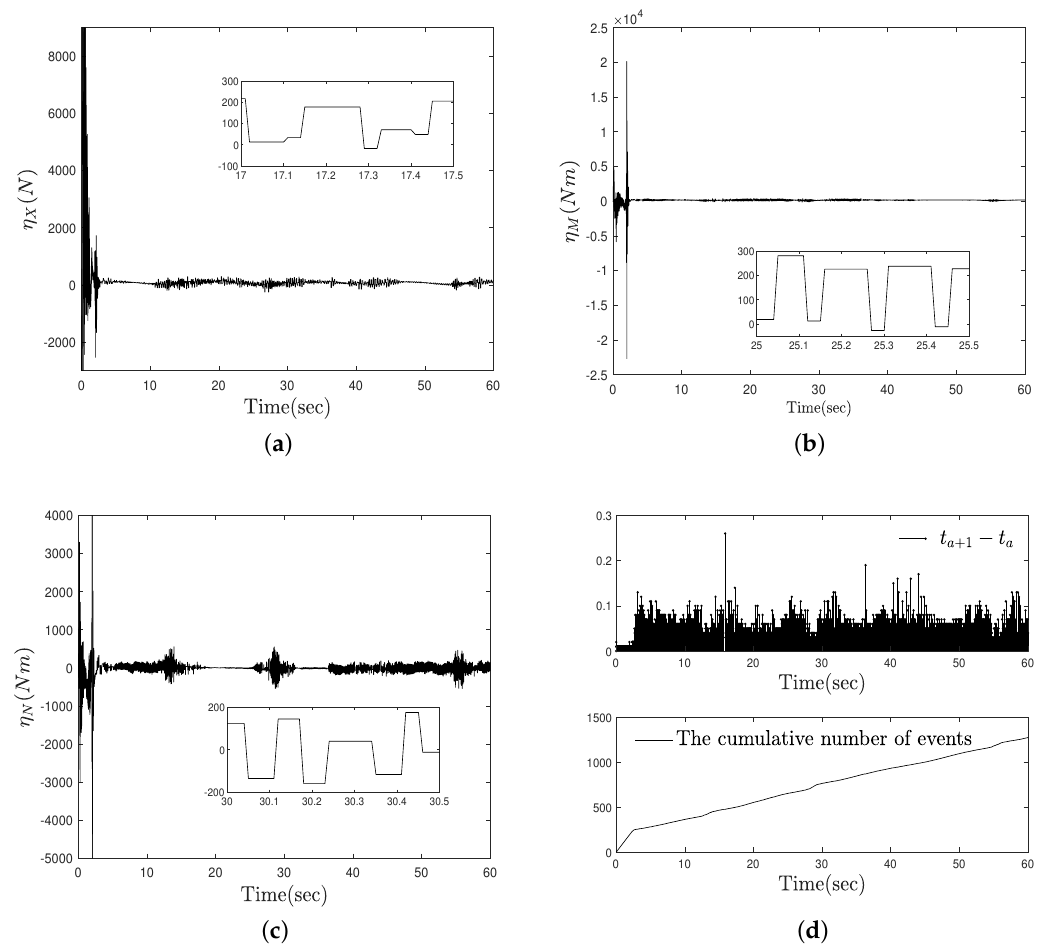
Figure 7. Event-driven control laws, inter-event times, and the cumulative number of events of the proposed approach for Scenario 1 ( a ) η X ( b ) η M ( c ) η N ( d ) inter-event times and the cumulative number of